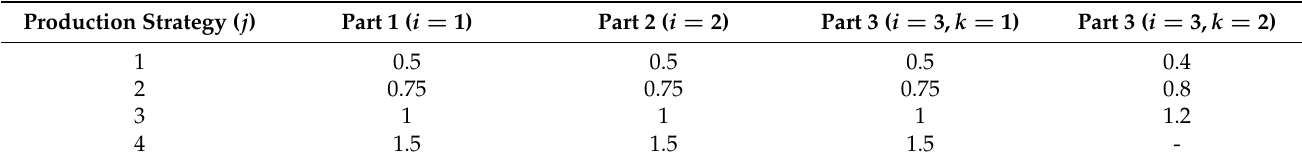
Table 3. Production scenario of each part and the resulting tolerances.